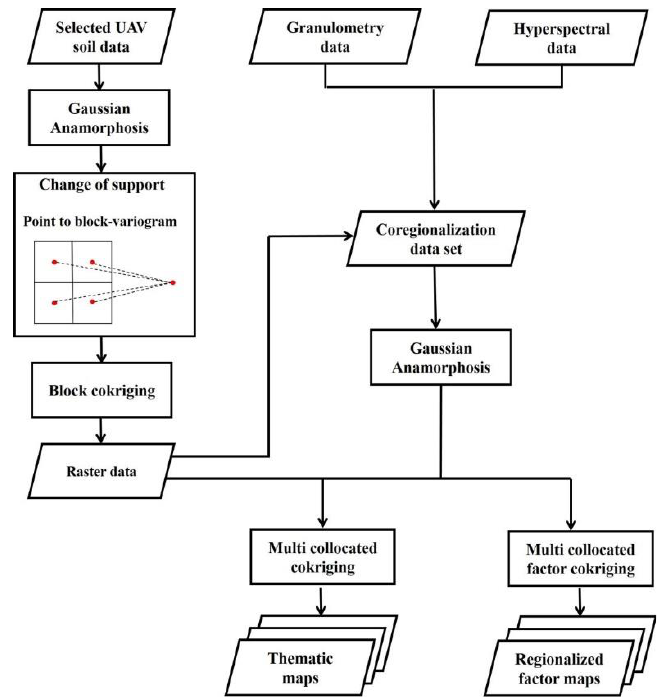
Figure 5. A flowchart of the proposed